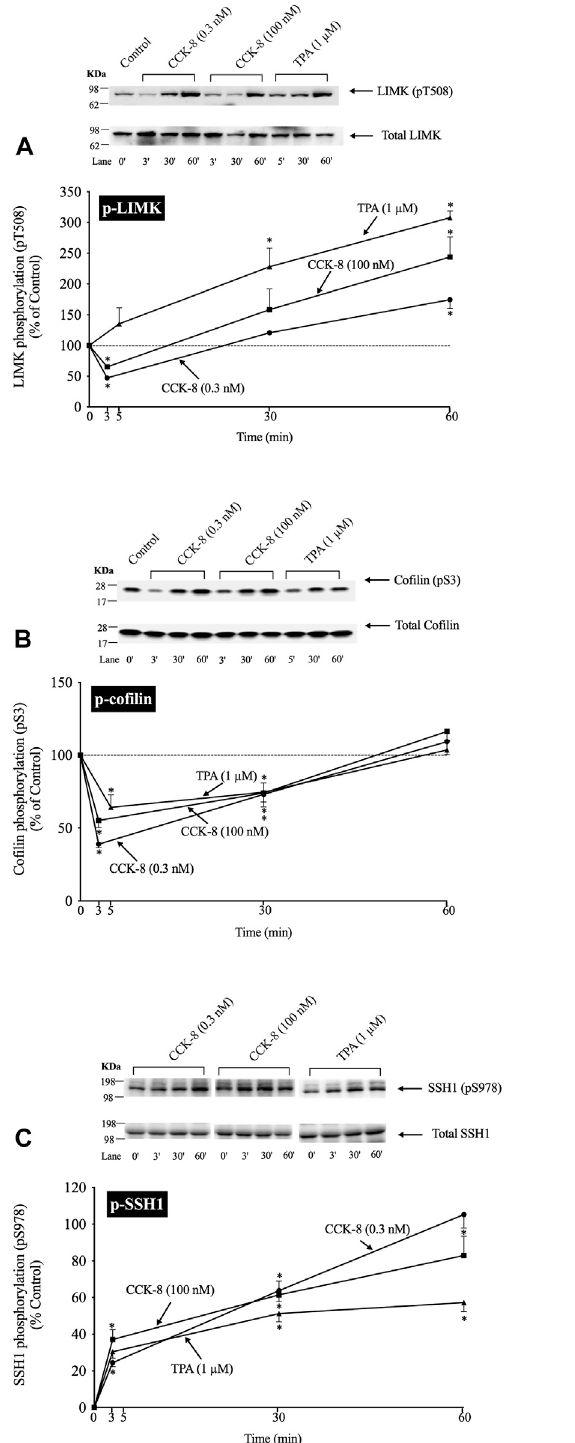
FIGURE 2 Time course of phosphorylation of Lim kinase (LIMK) (A) , co fi lin (B) and Slingshot 1 phosphatase (SSH1) (C) induced by CCK-8 and TPA. Isolated pancreatic acini were incubated with either no addition (control), CCK-8 (0.3 and 100 nM) or TPA (1 µM) for the indicated periods of time and then lysed. Western blots were analyzed using anti-pT508 LIMK, anti-pS3 co fi lin and anti-pS978 SSH1, which mediate the activation states of LIMK, co fi lin and SSH1. Bands were visualized using chemiluminescence and quanti fi ed by densitometry. Top : Results of a representative blot of three independent experiments are shown. Bottom : Means ± S.E. of at least 3 independent experiments. Results are expressed as % of basal stimulation of the control group. *, p < 0.05 compared to the control